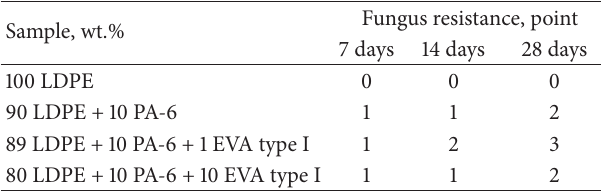
Table 3: Assessment of biodeterioration of polymer blends for various incubation times where 0 point: lack of microorganisms on the surface of sample; 1 point: traces of microorganisms (less than 10% of the coating covered by fungal growth); 2 points: insignificant growth (10% to 30% of the coating covered by fungal growth); 3 points: significant growth of microbial colonies (30–60% of the coating covered by fungal growth). Sample,